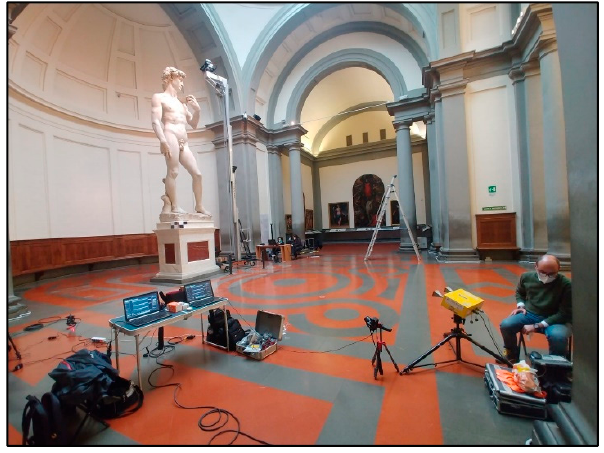
Figure 9. View the instrumentation set-up and arrangement within the La Tribuna room. The measuring systems were positioned at 45° from the gantry longitudinal side and at a distance of approximately 11 m (Figure 10).